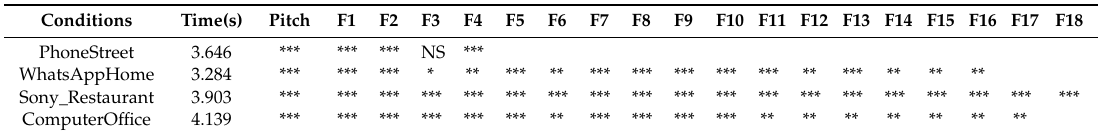
Table 9. The results of the confrontation between the suspects (Sentence #1) and, reference (Sentence #1) recorded after 30 days, considering noise and various recorder